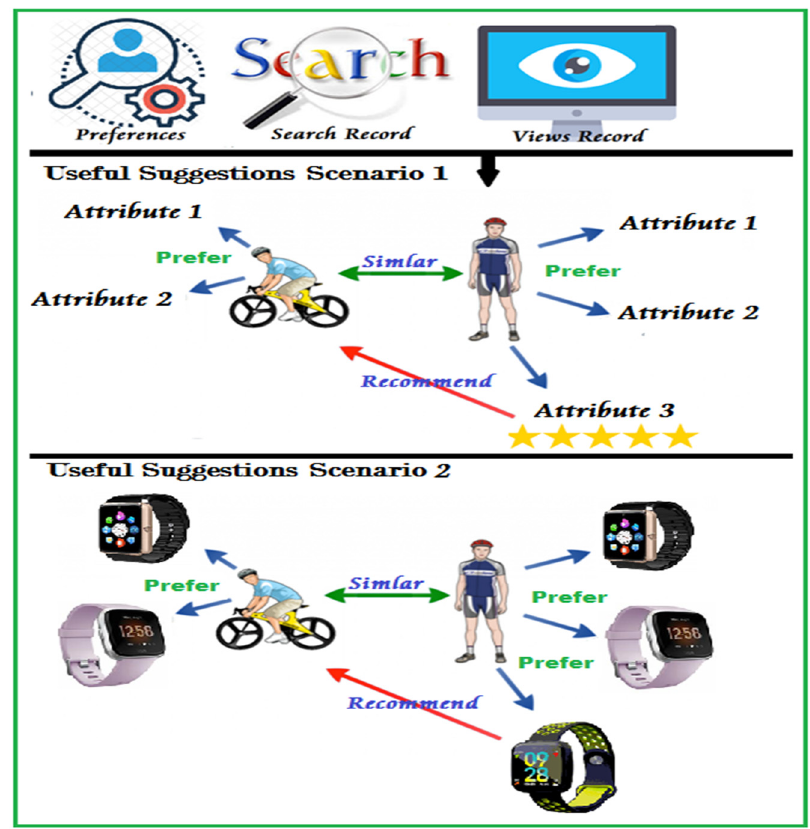
Figure 7. Example for recommending a user using items similarities.